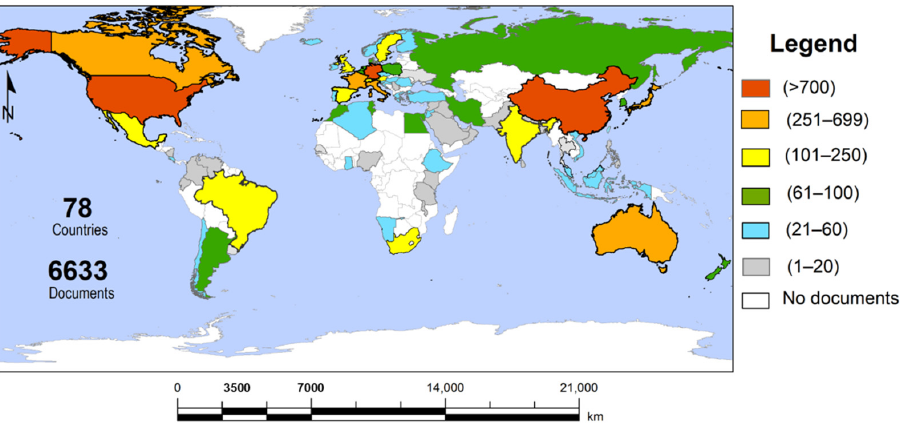
Figure 4. Countries contribution to GSI.